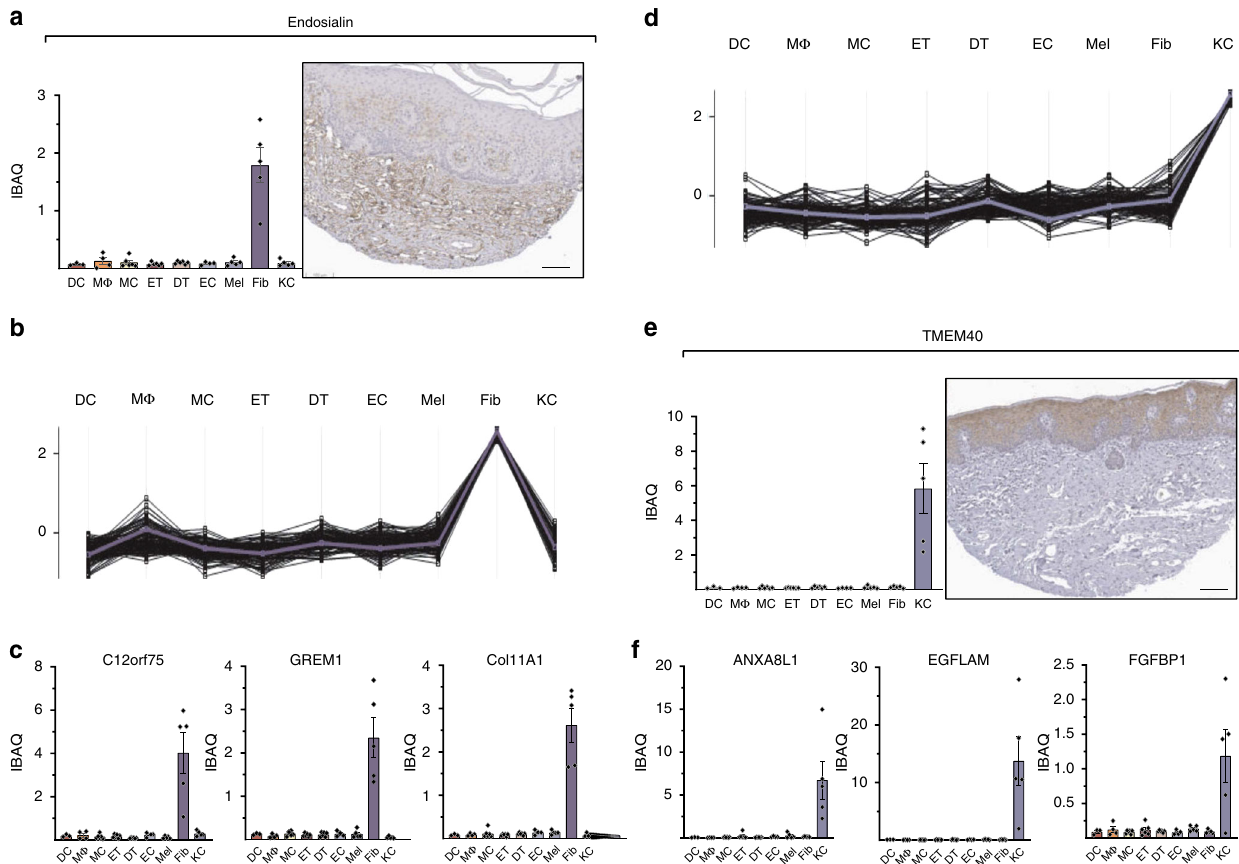
Fig. 4 The proteomes of cultivated fi broblasts and keratinocytes. a MS-intensity (iBAQ) of endosialin across cell types (left upper panel) compared to its immunohistochemical staining obtained from the Human Protein Atlas (Scale bar: 100 µ m, see Methods and Supplementary Data 17). b Protein abundance pro fi les of the top 100 proteins across cell types with the most similar fi broblast-enriched pro fi le as endosialin (reference pro fi le, blue line). Each line represents one protein. c MS-intensity of selected fi broblast-enriched proteins (GREM1, Col11A1, c12orf75,) across cell types. d Protein expression pro fi les of the top 100 proteins across cell types with the most similar keratinocyte-enriched pro fi le as KLK10 (blue line). e iBAQ values of the keratinocyte- enriched protein TMEM40 across cell types and its immunohistochemical staining obtained from the Human Protein Atlas (Scale bar: 100 µ m, see Methods and Supplementary Table 17). f MS-intensity of selected keratinocyte-enriched proteins (ANXA8L1, EGFLAM, FGFBP1) across cell types. All barplots show estimated intensity (data are presented as mean±SEM (IBAQ, log2)). DC; CD1A + dendritic cells ( N = 3), M Φ ; macrophages ( N = 4), MC; mast cells ( N = 6), DT; dermal T cells ( N = 6), ET; epidermal T cells ( N = 6), EC; endothelial cells ( N = 4), Mel; melanocytes ( N = 5), Fib; fi broblasts ( N = 5), KC; keratinocytes ( N = 5). Source data are provided as a Source Data fi